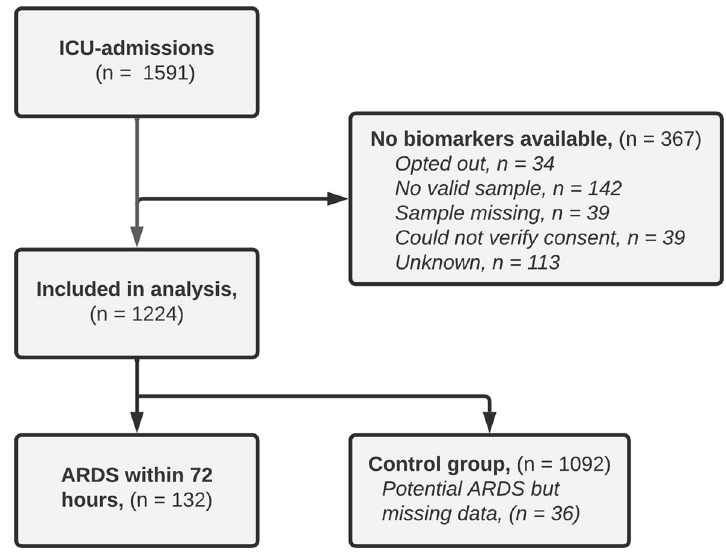
Fig. 1 Flowchart of the study. ICU intensive care unit, ARDS acute respiratory distress